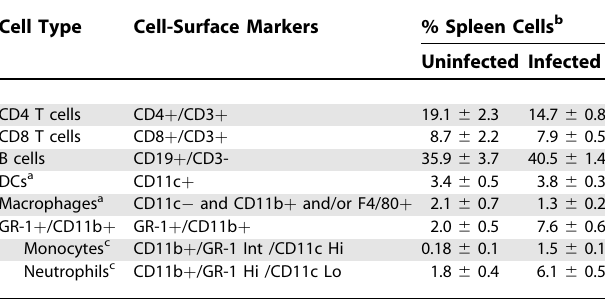
Table 1. FACS Analysis of Spleen Cells from Uninfected and Infected Mice Cell Type